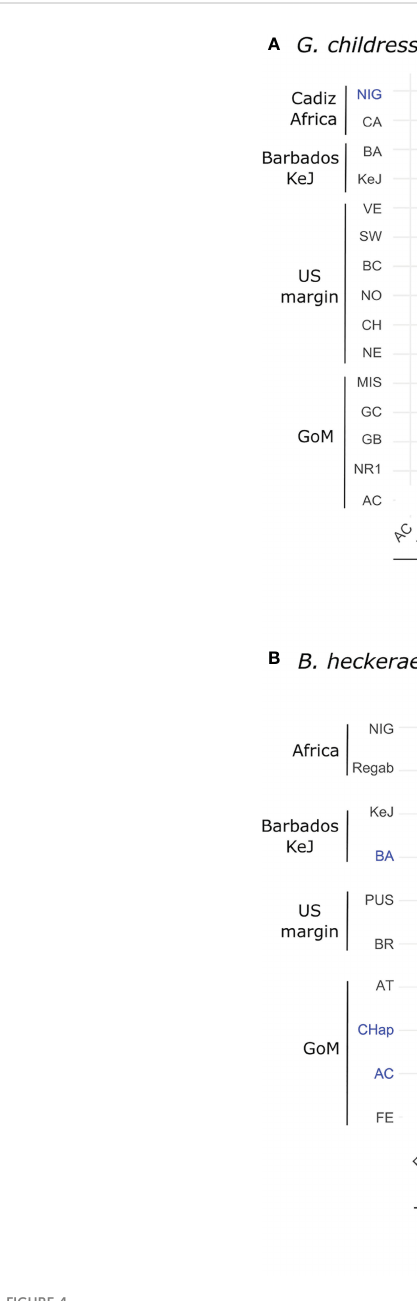
FIGURE 4 Pairwise Fst heatmaps for G. childressi/G. mauritanicus (A) and B. heckerae/B. boomerang (B) . Values are color-scaled and signi fi cance levels compared to zero are indicated using: *for p-value ≤ 0.05, **p-value ≤ 0.01 and ***p-value ≤ 0.001. Absence of asterisks indicates non-signi fi cant values and grey asterisks indicates Fst values for which signi fi cance was con fi rmed using either permutations or exact test of differentiation but not both. Populations for which less than 10 sequences were available are indicated in blue. Values for West African margin-Ivory (WAM) and Norfolk populations for G. childressi and B. boomerang , respectively, are not displayed since calculations involved only one sequence (see Table 2 for number of samples and population acronyms). GoM, Gulf of Mexico. Exact values and p-values are reported in Supplementary Tables S3,